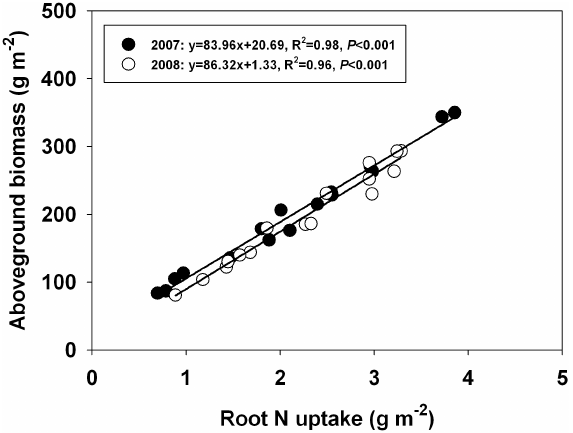
Fig. 6. The relationship between root N uptake and aboveground biomass in 2007 (solid circles) and 2008 (open